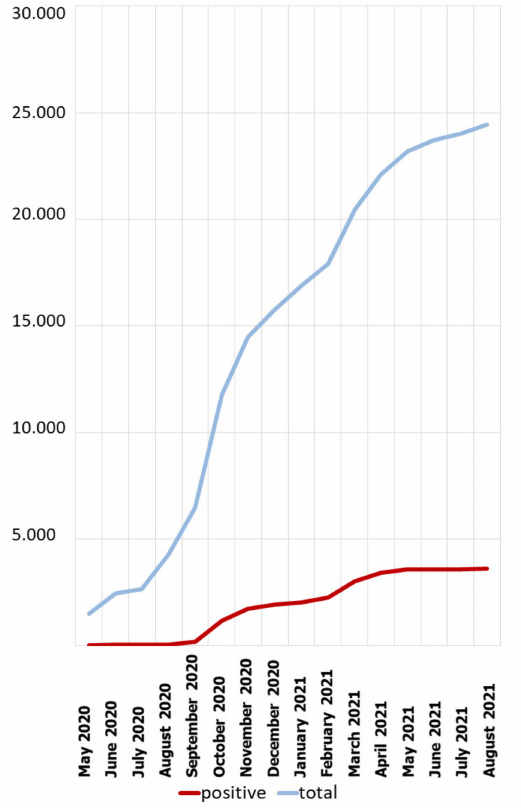
Figure 3. Total cumulative number of tests conducted over